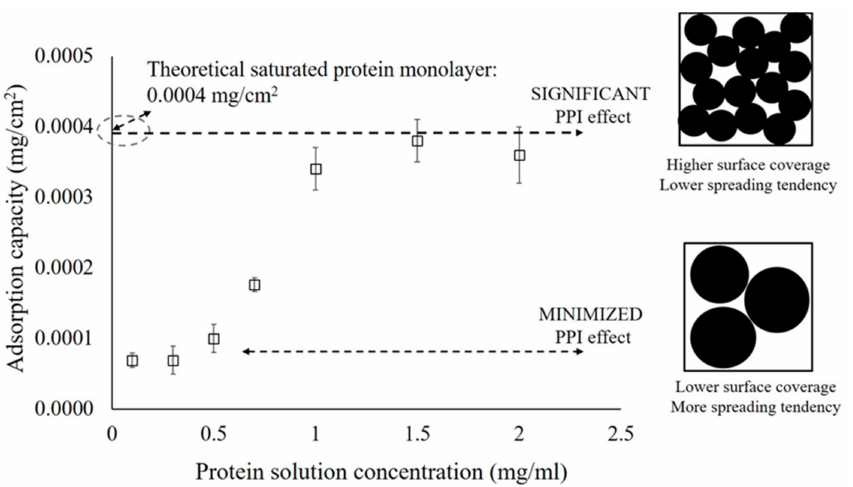
Figure 1. The adsorption capacity of the α -amylase protein on the glass surface at different concen- trations. The error bars denote the mean ± SD for n =